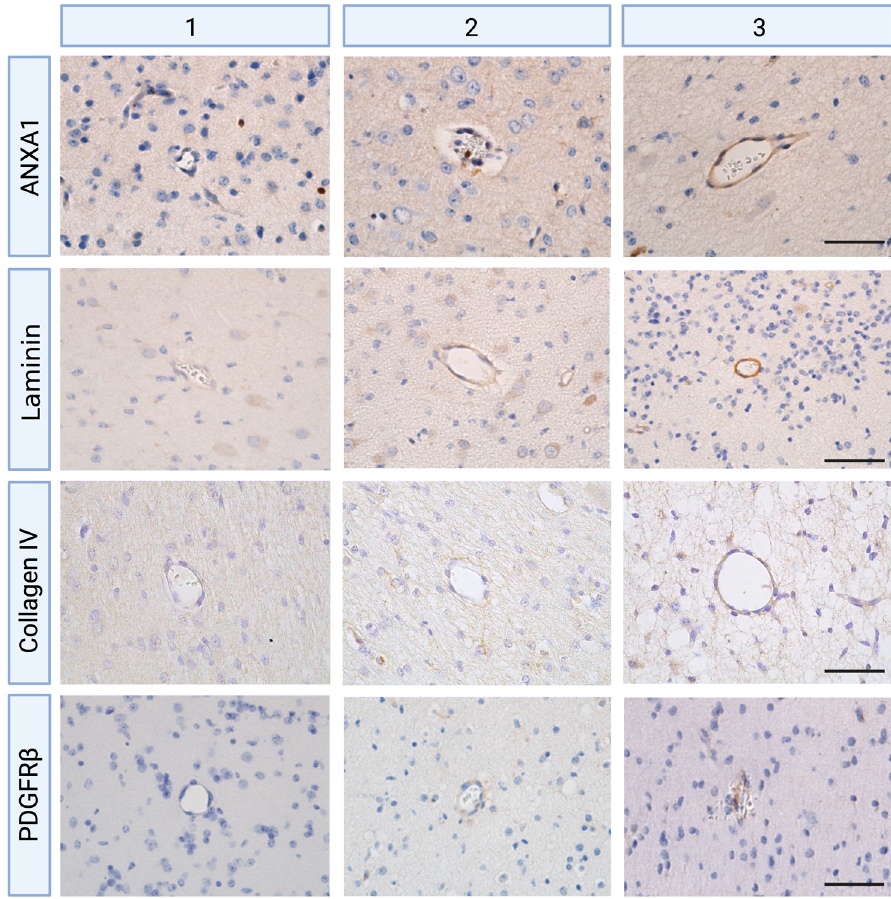
Figure 6. Scoring systems of ANXA1, laminin, collagen type IV, and PDGFR β in cerebral blood vessels (1 = minor, 2 = moderate, 3 = intense immunoreactivity (IR), magnification 400 × , scale bar 50 µ